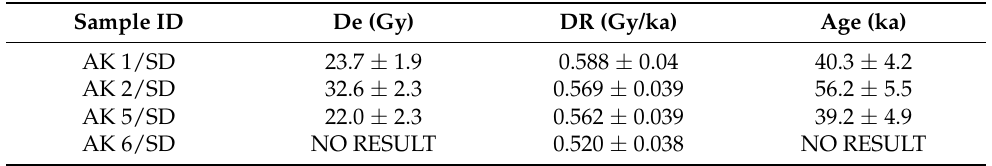
Table 2. Measured palaeodoses (Des), calculated total dose rates (DRs) and calculated ages derived using the OSL protocol after [20]. The grain size is 200–250 µ m for all